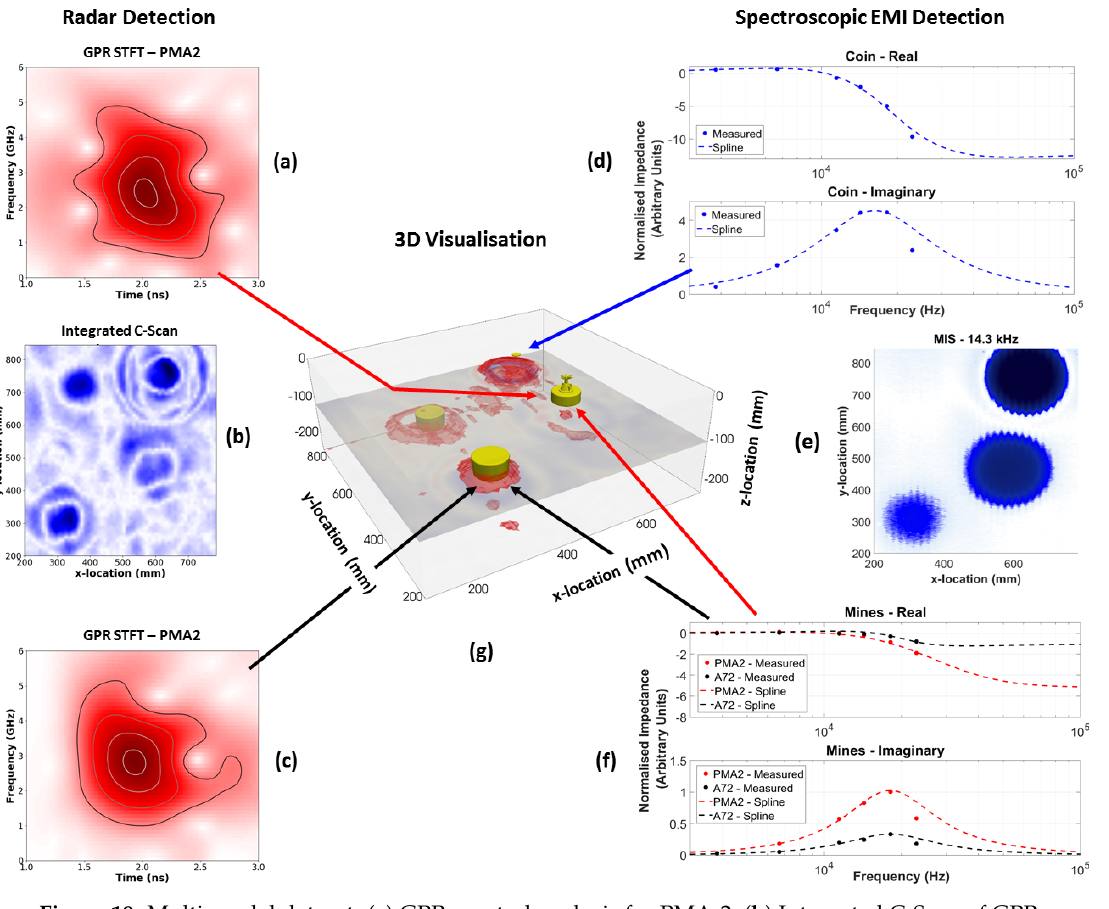
Figure 18. Multi-modal dataset: ( a ) GPR spectral analysis for PMA-2; ( b ) Integrated C-Scan of GPR data; ( c ) GPR spectral analysis of A72; ( d ) MIS analysis of coin; ( e ) MIS spatial analysis of test area